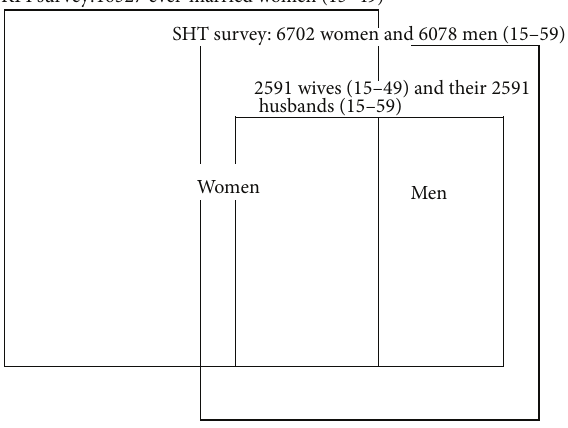
Figure1:ThestructureoftheEgyptianDHS2008andthederivation of the married couples subsample. 16527 ever-married women aged 15–49 were sampled in the key population indicators (KPI) survey. In a subsample of households surveyed in the KPI, 6702 women and 6078 men aged 15–49 were sampled in the special health topics (SHT) component. 2591 wives (aged 15–49) and their 2591 husbands (aged 15–59) could be linked to generate the married couples